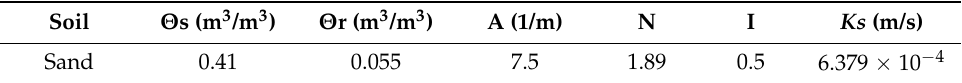
Table 2. Parameter values for the van Genuchten model function.